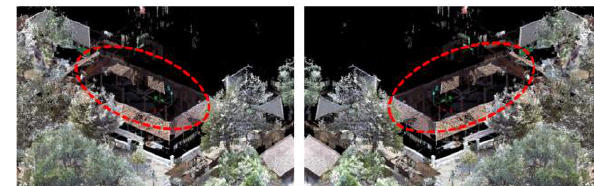
Figure 1. Incomplete building’s pointclouds on the roof part (denoted by red circle) as the result of Terrestrial Lidar acquisition.